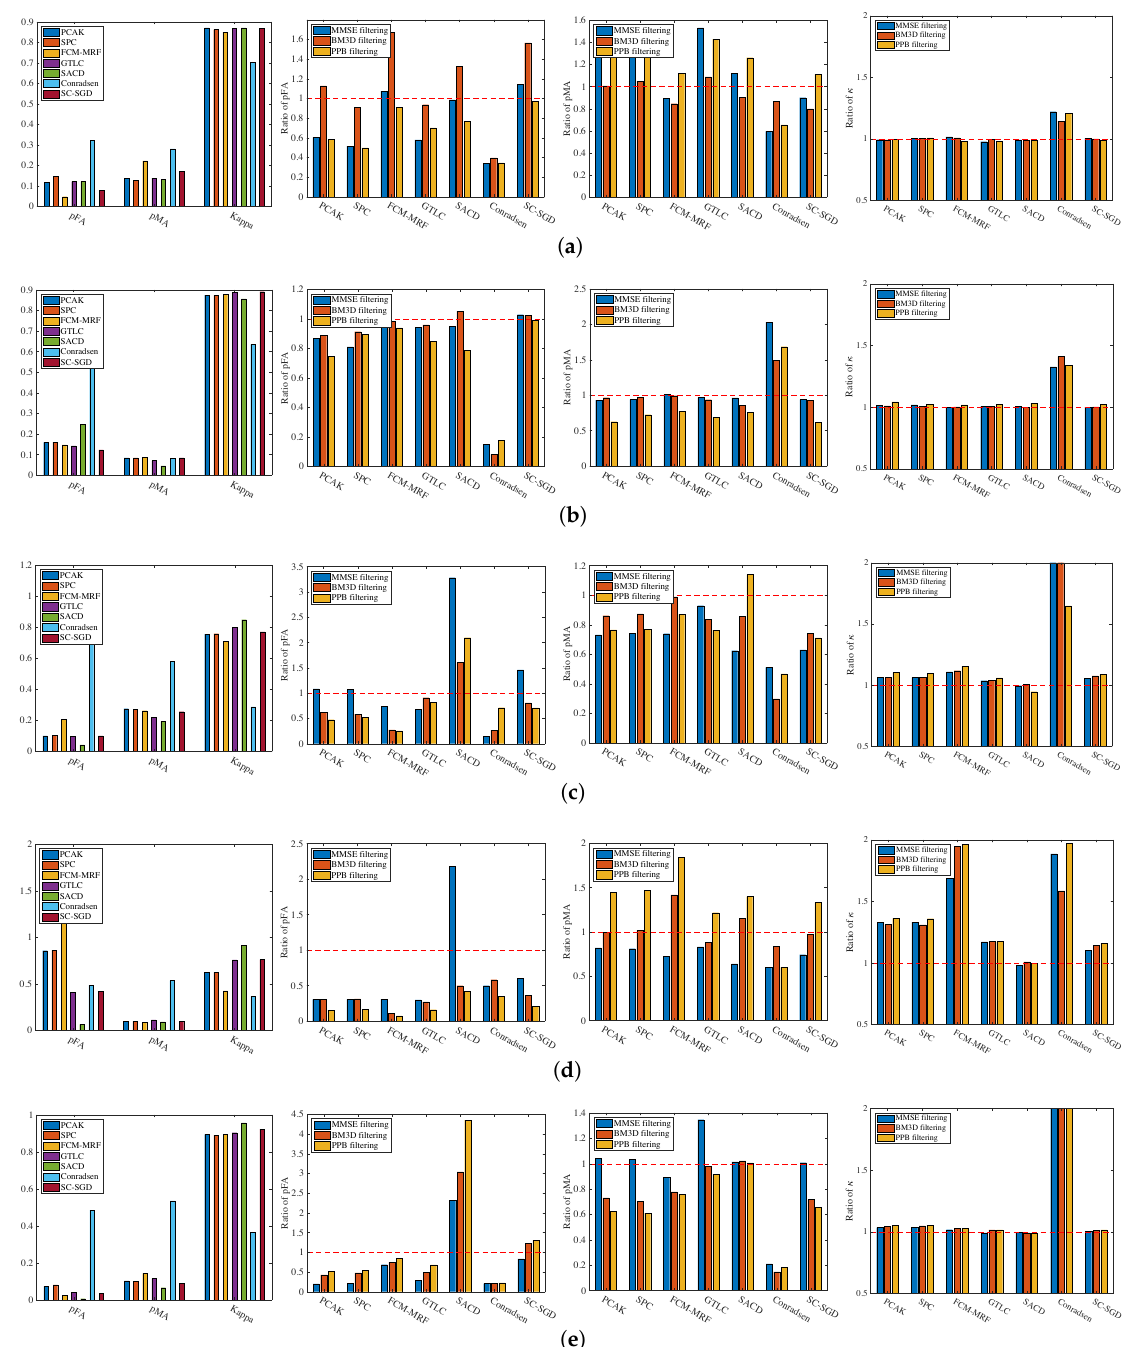
Figure 6. The performance of change detections on both raw and despeckled images. ( a ) Bern dataset. ( b ) San Francisco dataset. ( c ) Yellow River A dataset. ( d ) Yellow River B dataset. ( e ) Ottawa